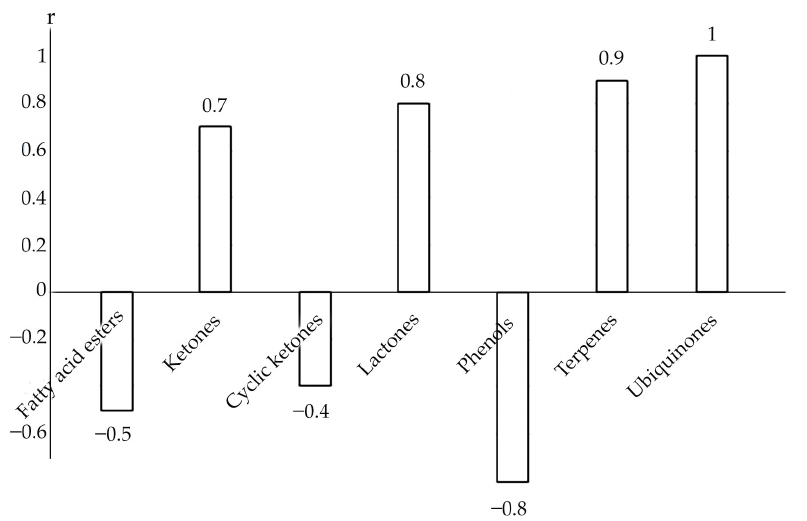
Figure 5. Influence of the vegetation phase on the correlation relationships of the accumulation of individual groups of SM in the root and shoot of R. semenovii .